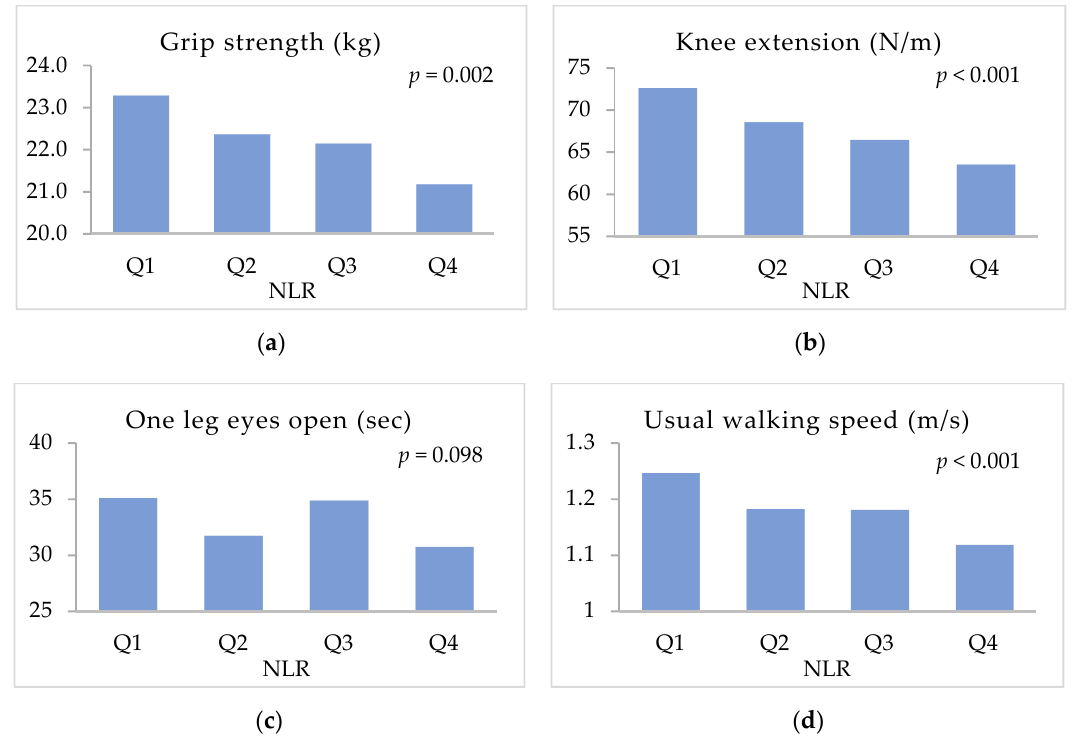
Figure 1. Variation of the adjusted means of physical functions with NLR level. ( a ) Grip strength; ( b ) knee extension; ( c ) standing on one leg with eyes open; and ( d ) usual walking speed. Results are based on the analysis of covariance adjusted for sex and age. Table 3 shows the results of the multivariable logistic regression analysis for associa- tions between NLR and physical function. NLR was negatively associated with physical function with respect to hand-grip strength (adjusted odds ratio [aOR] = 1.779, 95% confi- dence interval [CI] = 1.068–2.963 for Q4), knee extension (aOR = 1.800, 95 CI =